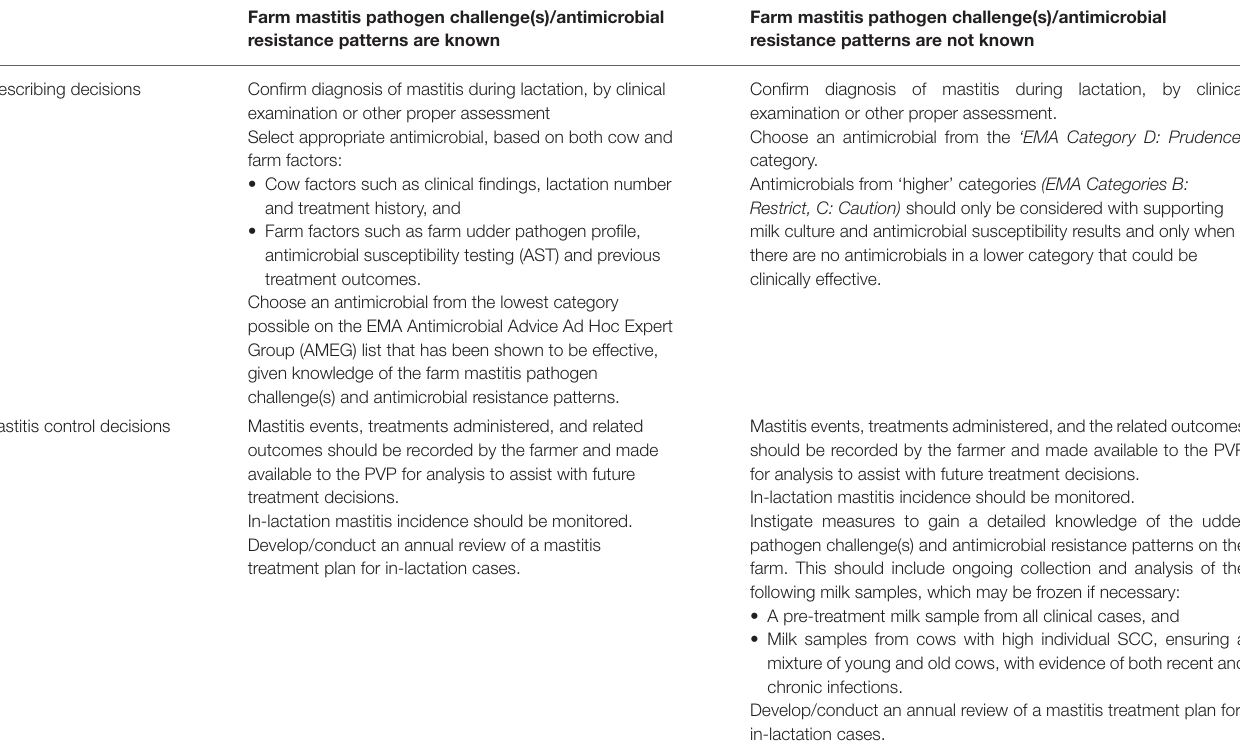
TABLE 3 | Proposed guidelines for the prescribing private veterinary practitioner (PVP) to support prescribing and mastitis control decisions during lactation. Farm mastitis pathogen challenge(s)/antimicrobial Farm mastitis pathogen challenge(s)/antimicrobial resistance patterns are known resistance patterns are not